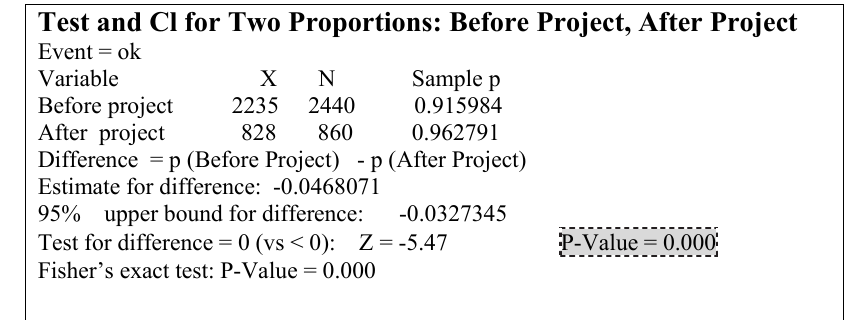
Fig. 16. Two Proportion Test for Overall Rejection